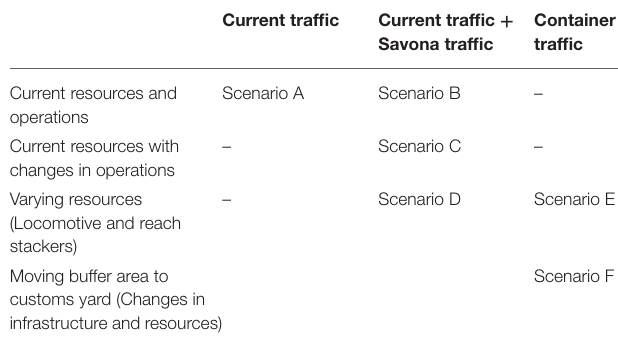
FIGURE 4 | Simulation window in AnyLogic.